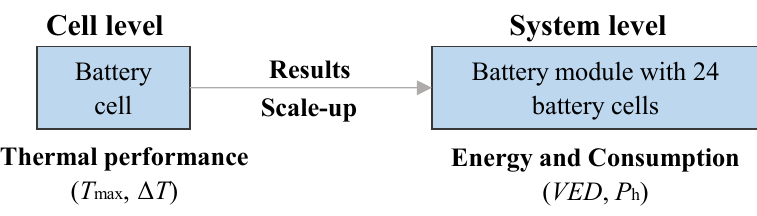
Figure 11. Output variable analysis level explanation.